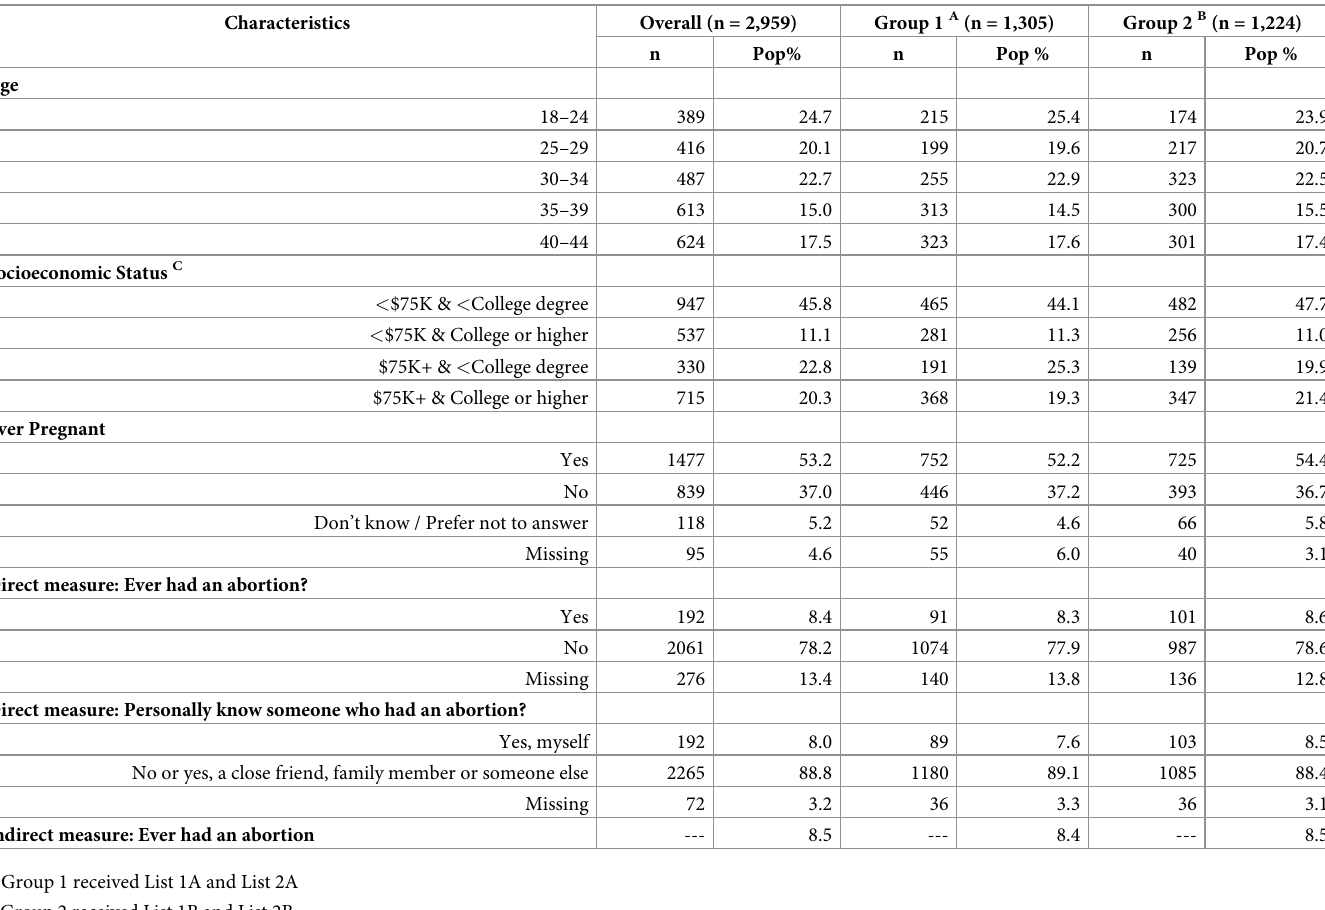
Table 1. Demographics characteristics of the Ohio Survey of Women, overall and by the two versions of the survey (n = 2,529). Characteristics